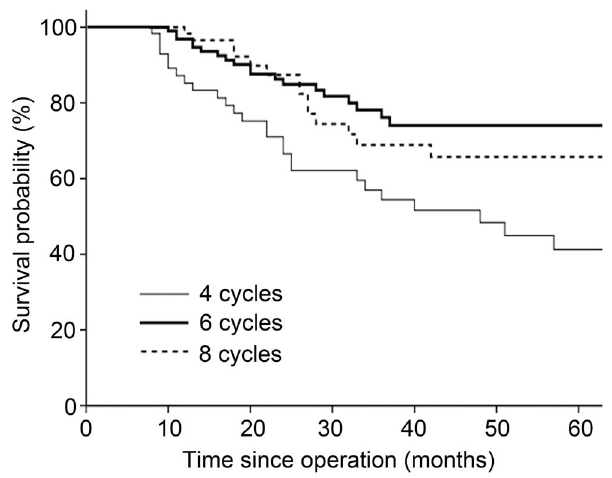
Figure 1. Kaplan-Meier survival curves by number of treatment cycles in all patients.